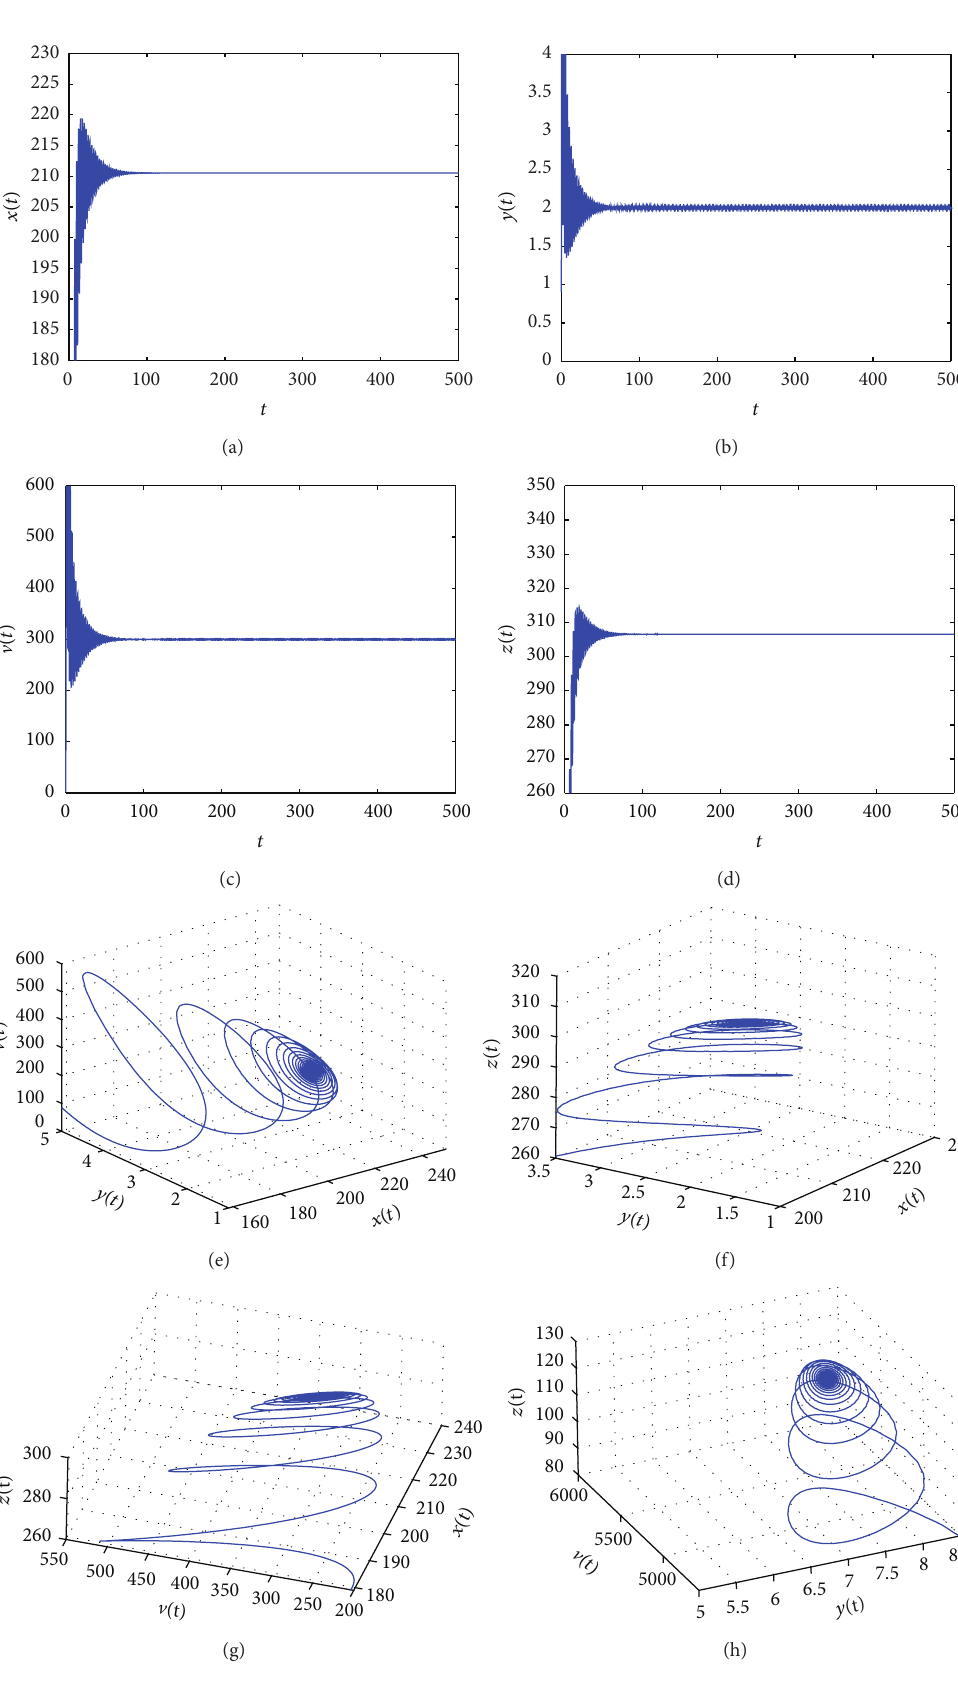
Figure 1: The time histories and the phase trajectories of system (50) before Hopf bifurcation occurs for 𝜏 2 = 0.2145